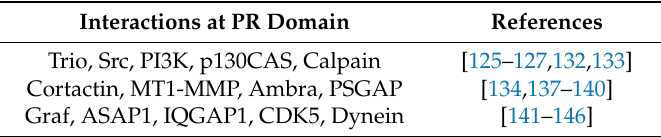
Table 1. Proteins associating with the PR domains are